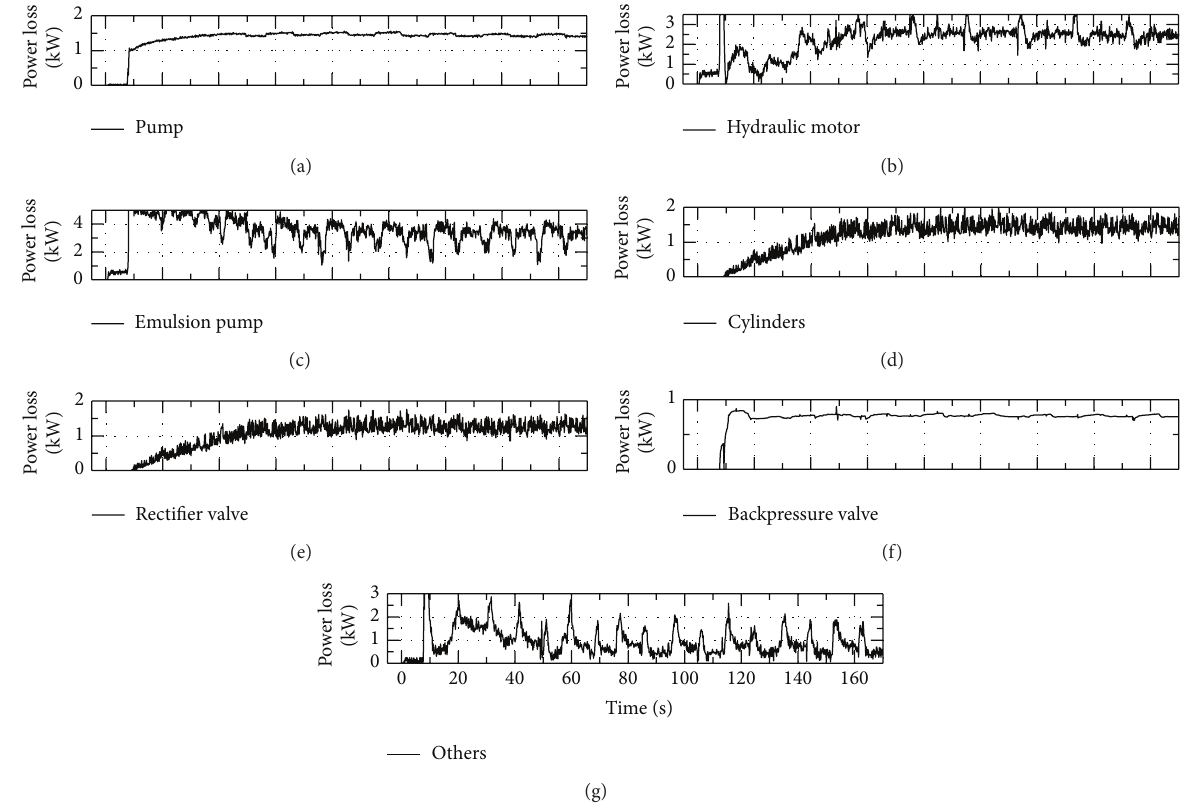
Figure 17: Power loss comparison of major components by